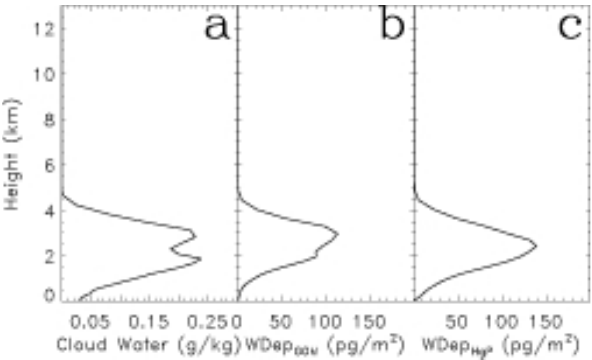
Fig. 12. Mercury concentration in rainfall from a stratiform event (yellow) and thunderstorms simulations c2500s5p50_s, c2500s10p50_s, c2500s5p60_s and c2500s10p60_s (black). All simulations are initialized with identical GOM and HgP conditions.